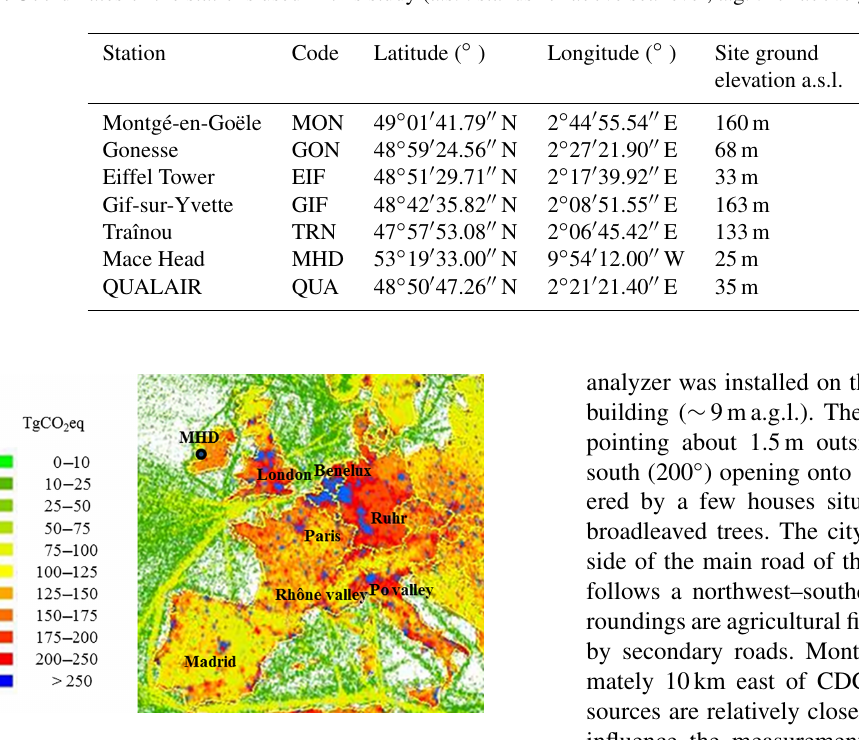
Figure 2. Location of the Paris megacity on a map of CO 2 anthro- pogenic emissions from western Europe, adapted from the EDGAR 2009 inventory (http://edgar.jrc.ec.europa.eu/, 2009). Emissions are given in Tg of CO 2 eq. per grid cell (10 × 10km 2 ) . Some of the main emitting points in western Europe are also given. The geo- graphical position of the remote site of MHD on the west coast of Ireland is also